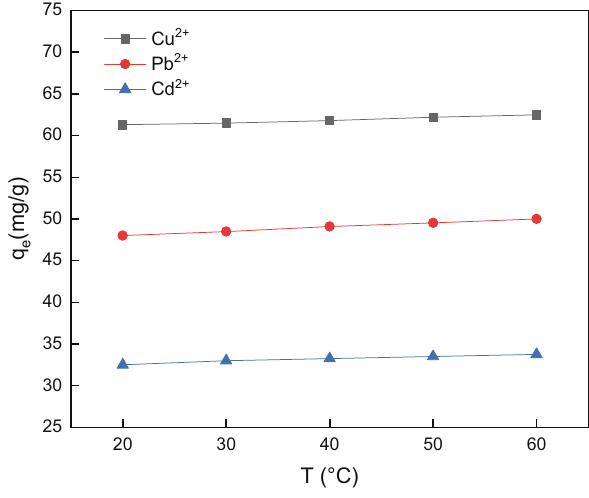
Figure 6: E ff ect of adsorption temperature on the adsorption of Cu 2 + , Pb 2 + , and Cd 2 + by GC.